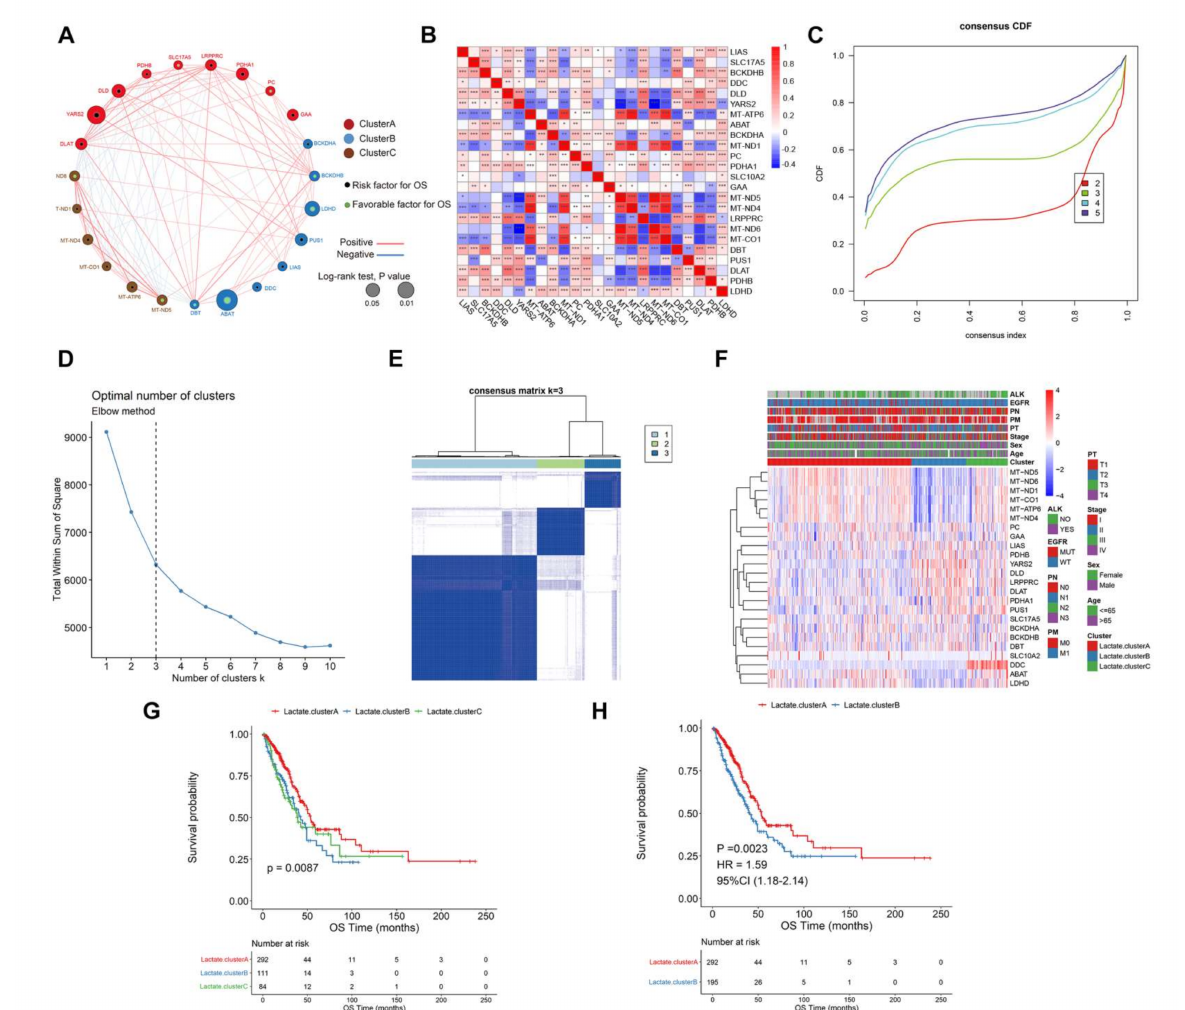
Figure 2. Survival patterns that were classified by 24 lactate metabolism-associated genes. ( A ) Lactate metabolism-associated genes were classified into three clusters according to OS correlation. A log- rank test was used to calculate the correlation between OS and lactate metabolism-associated genes ( p < 0.05, p < 0.01). ( B ) Pairwise correlation between lactate metabolism-associated genes ( p < 0.05). Red means positive correlation, blue means negative correlation, darker colors indicate stronger associations. ( C ) Representative CDF curves to display consensus analysis of the LUAD samples by an R package. ( D ) The optimal number of clusters was settled at three by the ELBOW method. ( E ) Sample correlation matrix depicted from consistent clustering. ( F ) A panoramagram of three clusters with clinical-pathologic features and lactate metabolism-associated gene distribution. ( G ). Kaplan–Meier curve and survival data of OS of three clusters ( p = 0.0087). ( H ) ClusterB and ClusterC were merged and compared with ClusterA ( p = 0.0023, HR =